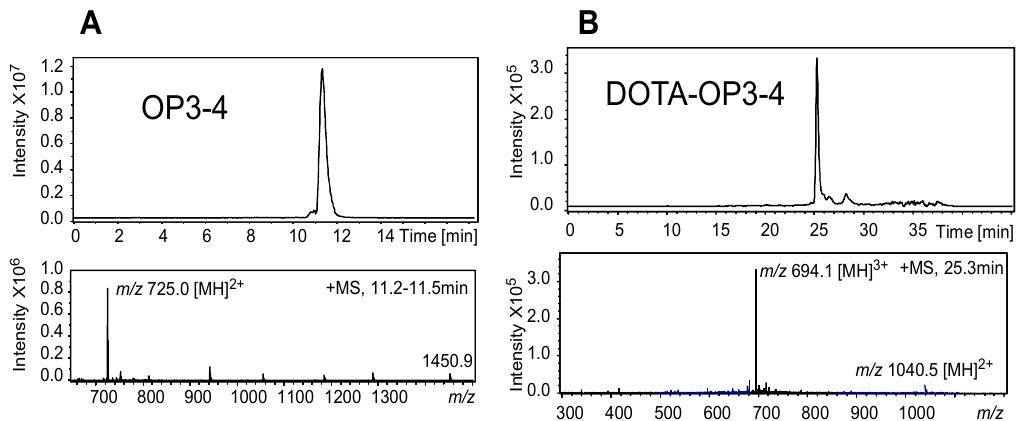
Figure 3. LC-MS chromatographic separation profile of the putative peptides (top) ( A ) OP3-4 ( m/z 1450.9) and ( B ) DOTA-OP3-4, ( m/z 2081.4) with their respective ITMS ion mass spectra (bottom) eluted as peaks at 11.2–11.5 and at 25.3 min. The purity of the putative peptides, estimated by integration of the peak areas, was >95% (OP3-4) and 90%